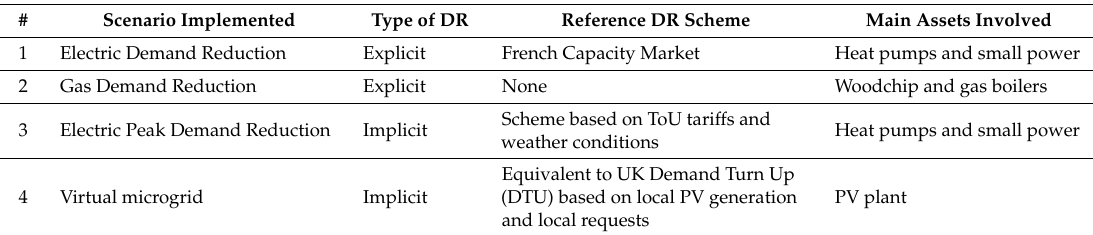
Table 2. DR scenarios and scheme implemented in the French pilot